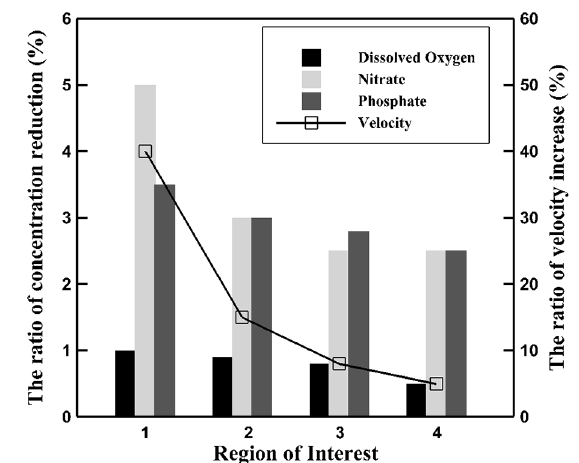
Figure 11. Ratio of concentration reduction and the ratio of velocity decrease at regions of interest when the designated water surface elevation